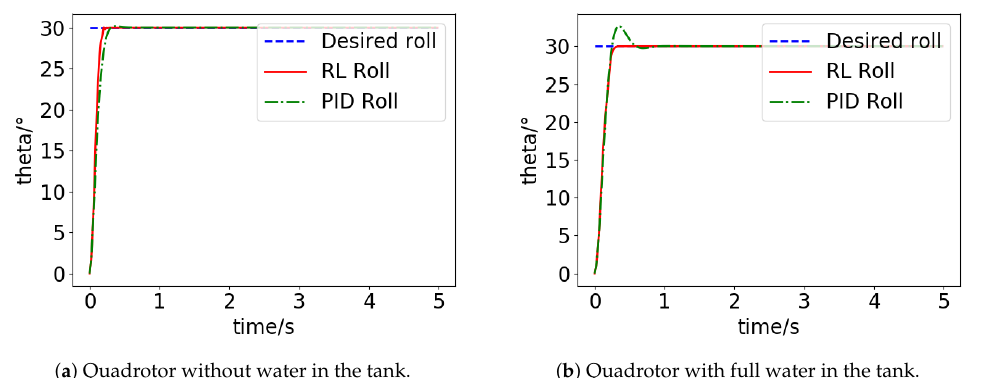
Figure 9. Step response test for controllers with sensor noise.